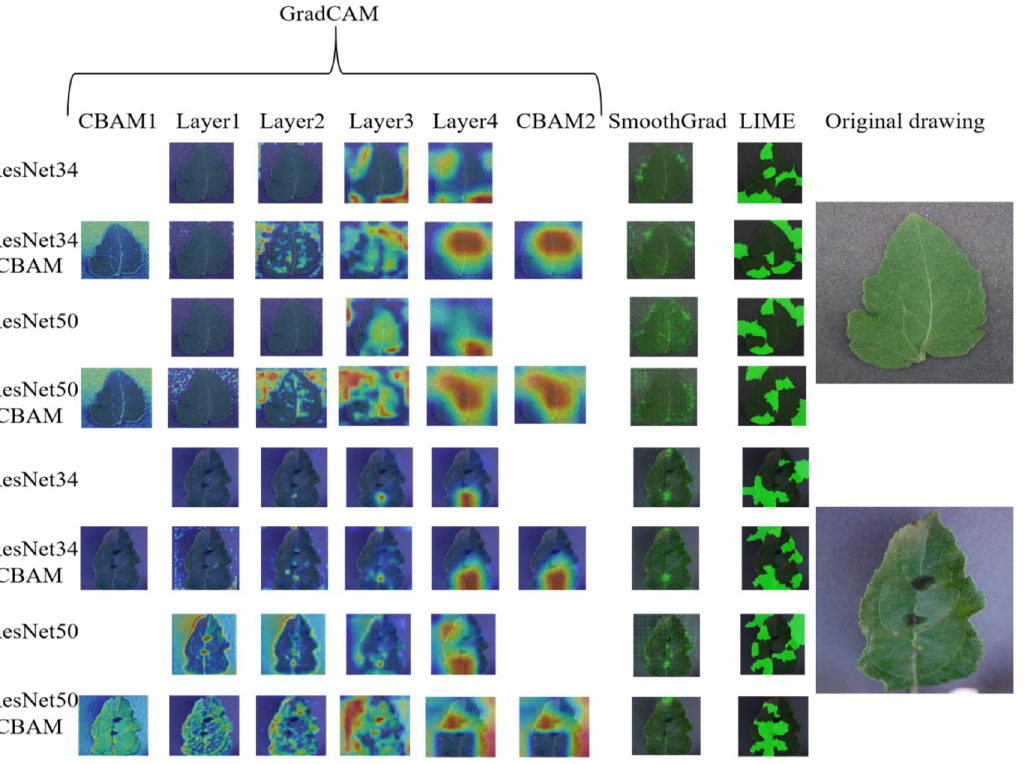
Figure 5. Visualization results of Experiment II. Each row represents the visualization result diagram of a model, and each column represents the effect diagram of GradCAM (including CBAM1, Layer1–4, and CBAM2 each layer result diagram. Layer1–4 corresponds to the four convolutional layers of random ResBlock in Figure 3), SmoothGrad, LIME, and the original image.